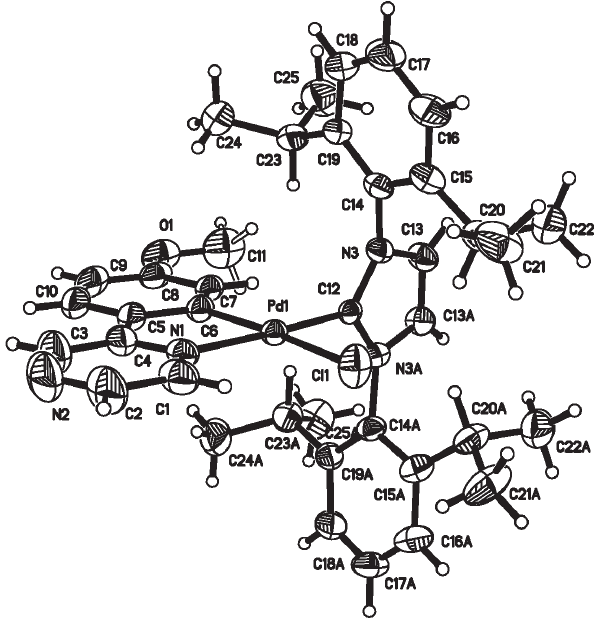
Table 1: Data collection and handling.